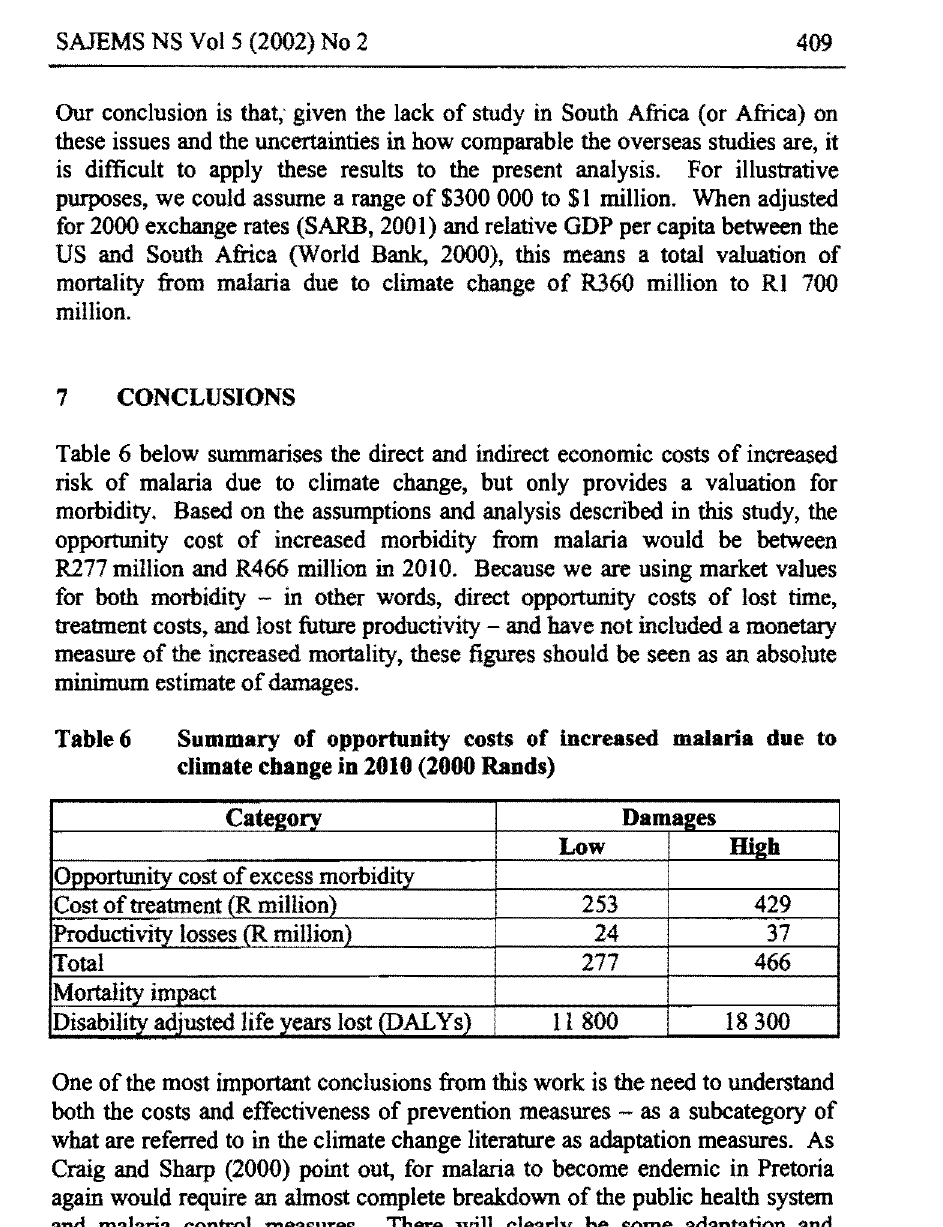
Summary of opportunity costs of increased malaria due